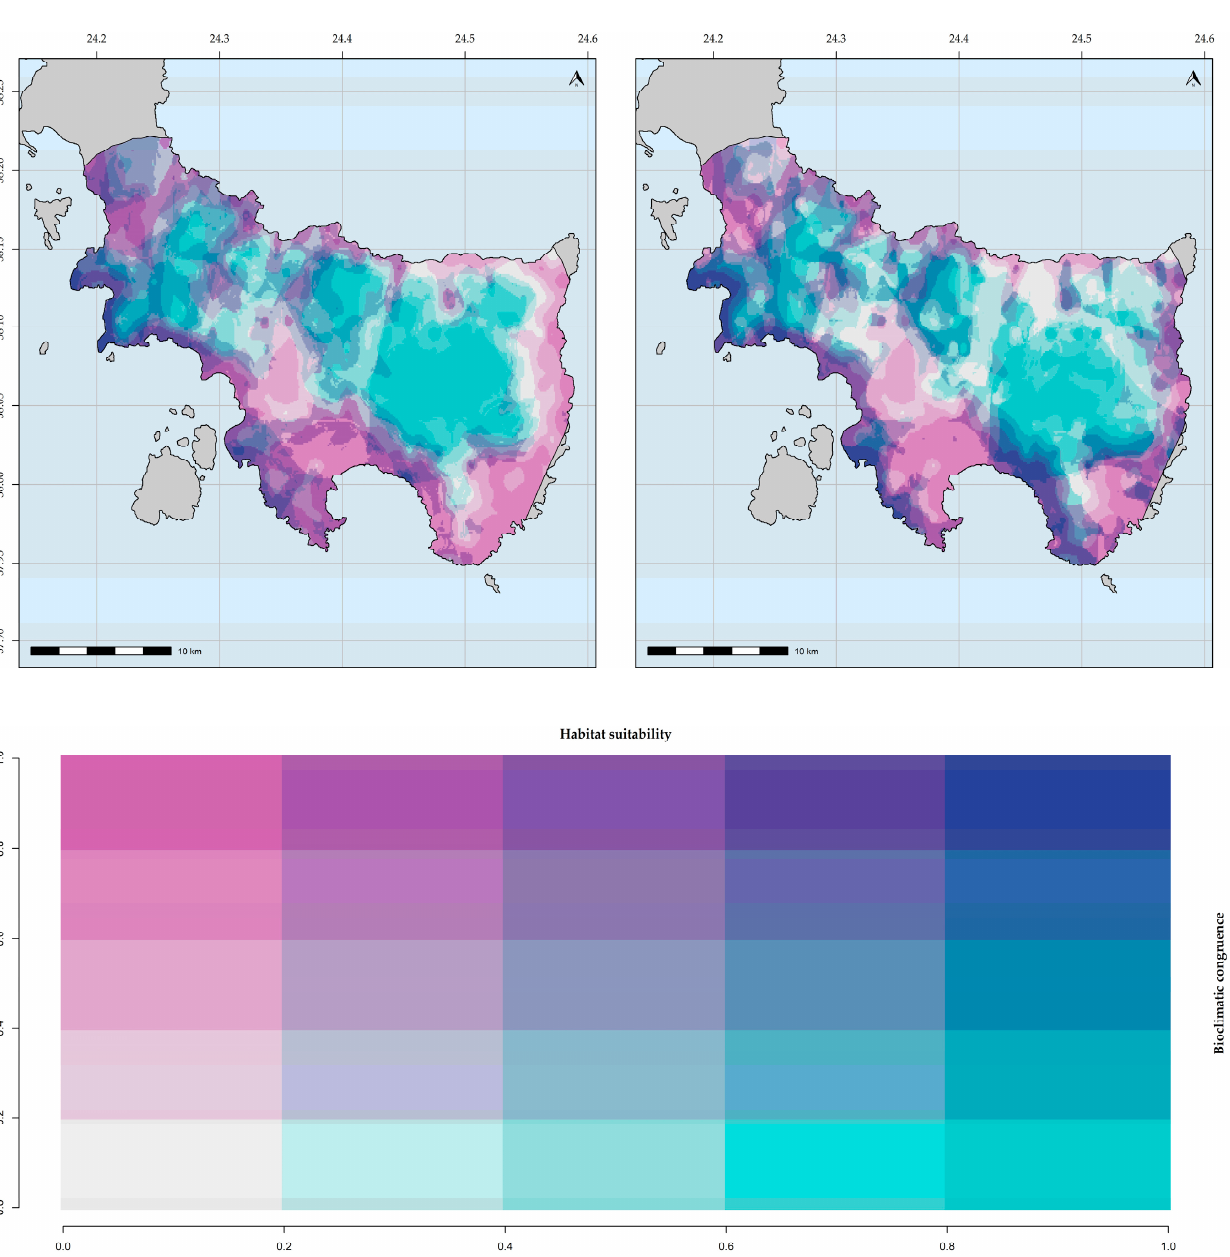
Figure 5. Bioclimatic consistency maps for Allium iatrouinum . From left to right: based on WorldClim; based on CHELSA. Our results indicate that, by 2070, Aethionema retsina and Allium iatrouinum will experi- ence severe range contraction any GCM/RCP/climate database combination (Figures 6 and 7 (WorldClim) and Figures S3–S22 (WorldClim and CHELSA)), since the median range con- traction is